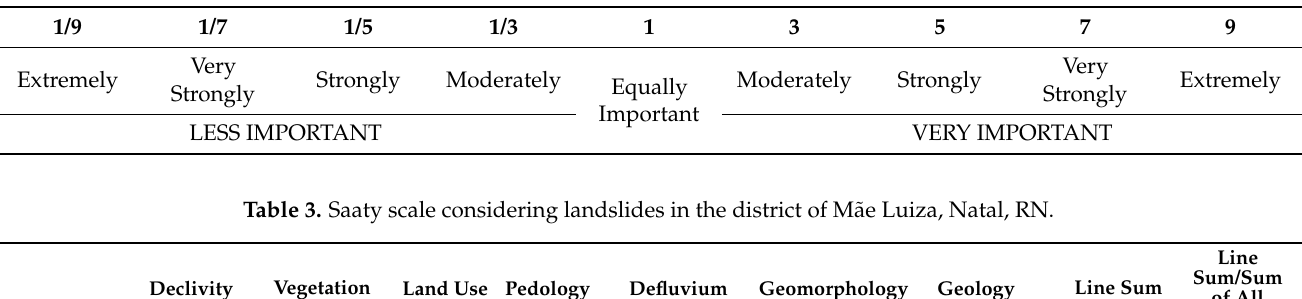
Table 2. Saaty scale applied as in Busman et al. (2016).